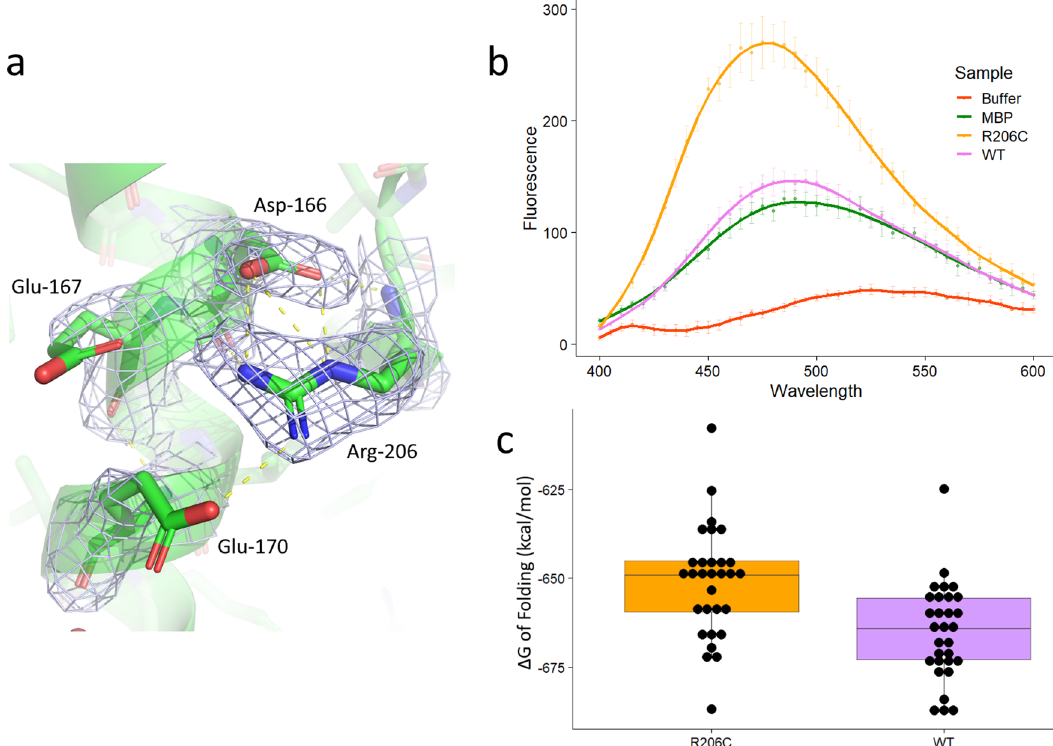
Fig. 2 The R206C mutation disrupts protein folding. a Electron density of Dnase1L3 Δ CTD chain C showing the salt-bridged network of Arg-206 joining two helical elements together. The distances indicated are 2.9 Å from Asp-166 to Arg-206, and 3.5 Å and 3.1 Å from Glu-167 and Glu-170, respectively. b Mean ANS (8-anilino-1-naphthalenesulfonic acid) fl uorescence for buffer, MBP (maltose-binding protein) alone, the Dnase1L3 WT-MBP fusion protein, and the Dnase1L3 R206C-MBP fusion protein. The error bars represent the mean from n = 3 independent measurements ± the standard deviation for each data point ( c ). Estimated Δ G of folding in kcal/mol of the WT enzyme and R206C, from 10 snapshots (10 ns apart) of the last 100 ns of each of the six simulations (three for WT and three for R206C, n = 30 independent calculations of free energy of folding). The free energy of folding was estimated using Rosetta. The difference between WT and the R206C mutation is 14.03 kcal/mol ± 3.79 (standard deviation), p = 0.000476, n = 30 independent calculations of free energy for WT and R206, each. The whiskers of the boxplot extend to the farthest data point that is no further than 1.5 times the interquartile range of the